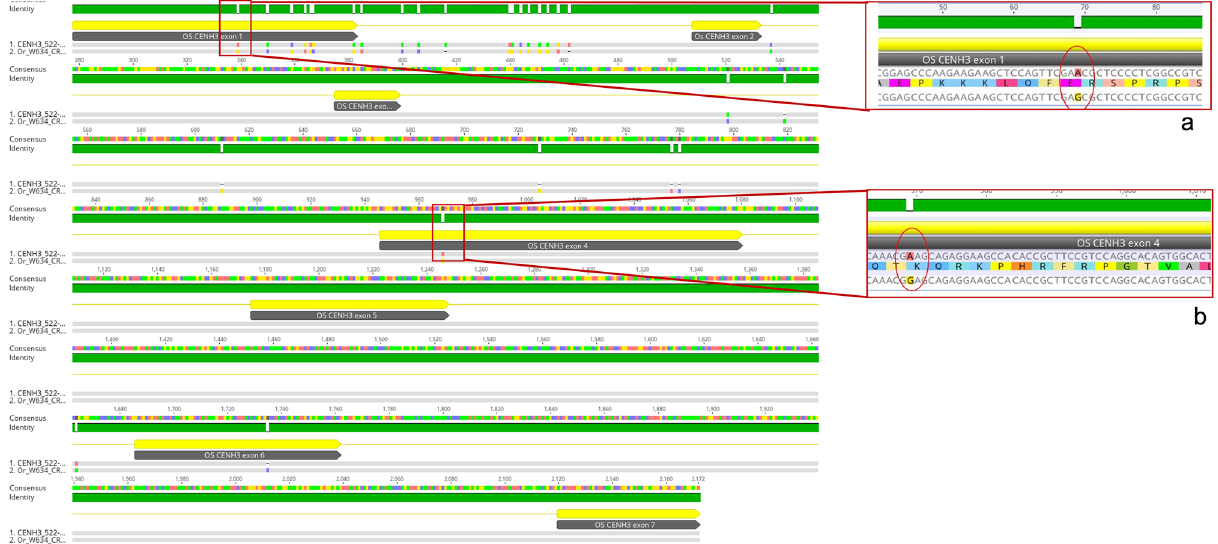
Figure 2. Alignment window of O. rufipogon accession CR100055 showing ( a ) a SNP at position 69/codon 23 in exon 1 of the CENH3 gene when compared to OsCENH3 reference. The SNP is highlighted in red circle. This variation is found in many other AA genome species accessions as well. ( b ) Non-synonymous substitution found in O. rufipogon accession CR100055 when aligned to reference at position 964/codon 61. Please also refer to Table 2. (The alignment was carried out using Geneious Prime version 2021.1.1; images were generated from Geneious Prime version 2021.1.1itself).